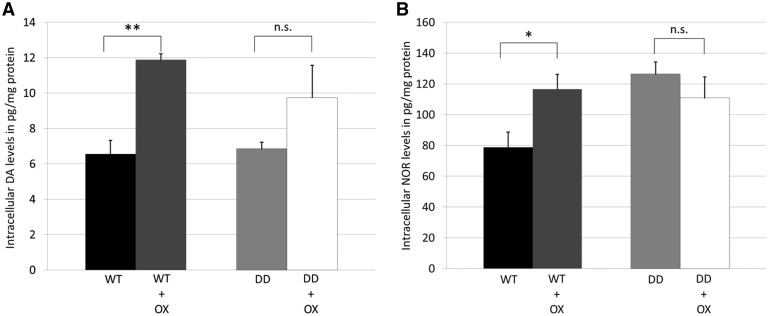
Treatment of cells with oxidative stress increased DA and NOR levels. (A,B) Catecholamine ELISAs to measure intracellular levels of noradrenaline (NOR) and dopamine (DA) in WT and DD cells following treatment with oxidative stress (OX; 1 mM BSO for 24 h and 1 mM H2O2 for 30 min). Catecholamine levels were calculated as pg/mg protein (n = 3). Statistical significance determined by Students T-test compared to respective control cell line. *P < 0.05; **P < 0.01; n.s., non-significant.